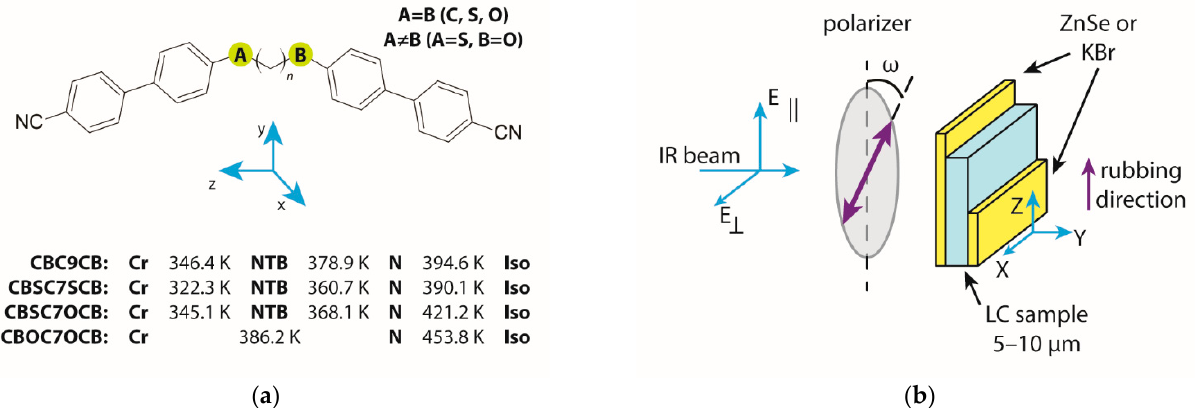
Figure 7. ( a ) Transition temperature and molecular structure of the cyanobiphenyl dimers with a molecular frame of reference: z—long axis (bowstring), x—axis normal to the bent plane, y—bow arrow axis. ( b ) Schematic of the polarized infrared transmission technique at a normal incidence of light. The planar cell’s laboratory frame (X, Y, Z). In the nematic phase, Z was the axis along and X was perpendicular to the optical axis (the optical axis coincided with the rubbing direction). In the